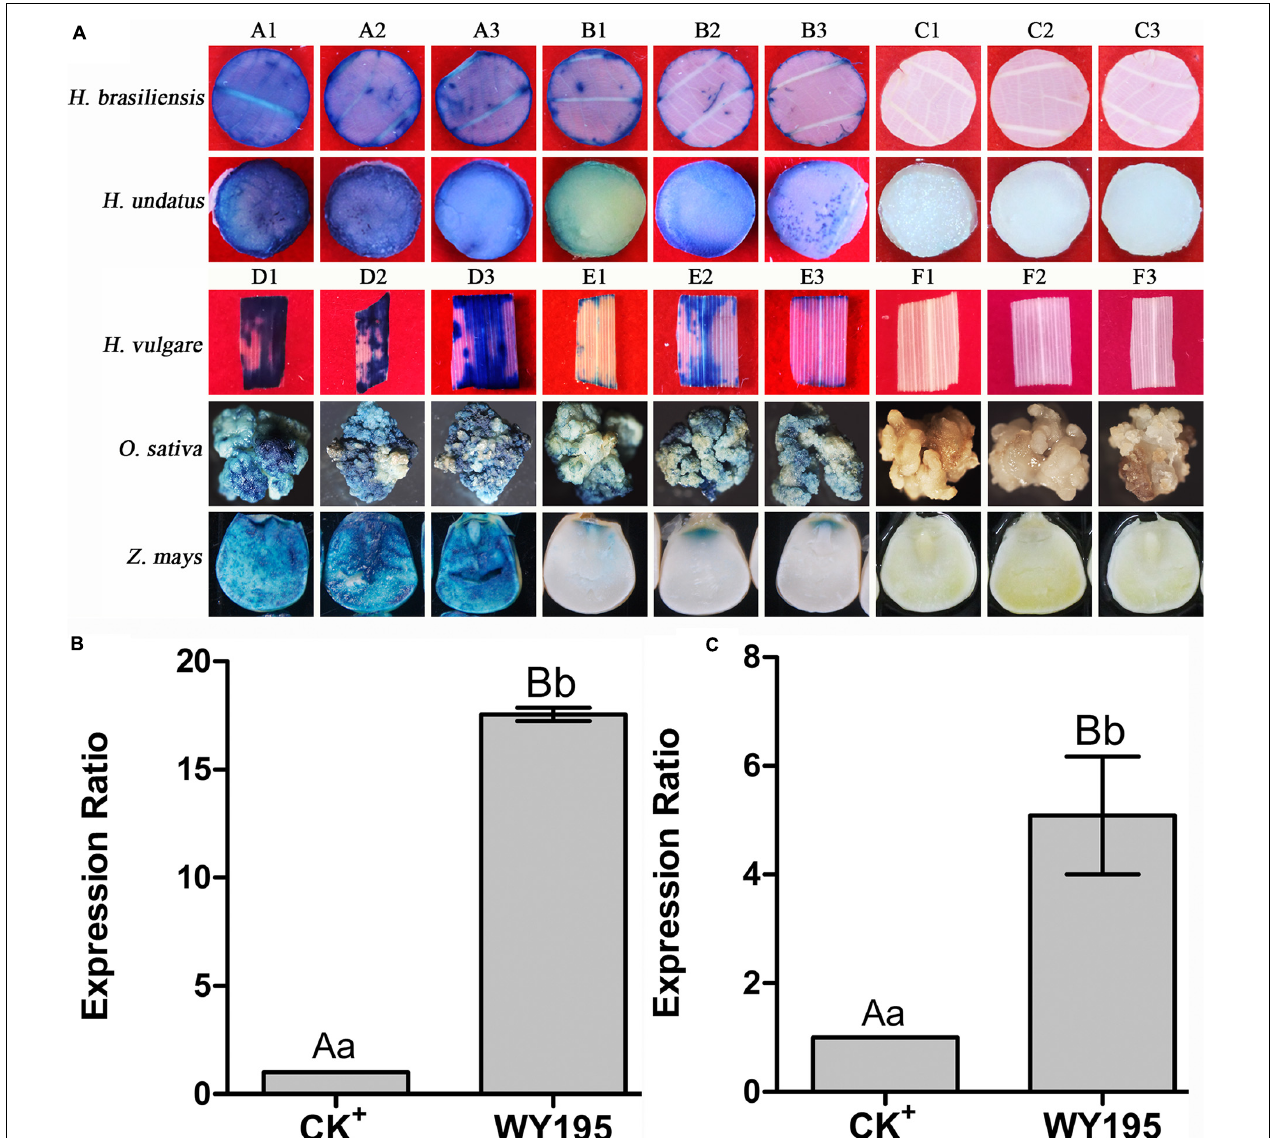
FIGURE 2 | GUS transient expression regulated by WY195 promoter in monocotyledons and dicotyledons. (A) Histochemical staining for GUS activity in transient transformed dicotyledons and monocotyledons. (A1–A3) GUS activity in dicotyledons regulated by the WY195 promoter; (B1–B3) CK + , positive control, GUS activity regulated by the 35S promoter; (C1–C3) CK − , negative control, GUS activity in wild type. (D1–D3) GUS activity in monocotyledons regulated by the WY195 promoter; (E1–E3) CK + , positive control, GUS activity regulated by the ACT1 promoter; (F1–F3) CK − , negative control, GUS activity in wild-type. (B) Transient expression level of GUS regulated by WY195 promoter in dicotyledons ( N. tabacum ); CK + , 35S. (C) Transient expression level of GUS regulated by WY195 promoter monocotyledons ( O. sativa ); CK + , ACT1 promoter. Different lowercase letters indicate a significant difference ( P < 0.05), and different uppercase letters indicate a very significant difference ( P <